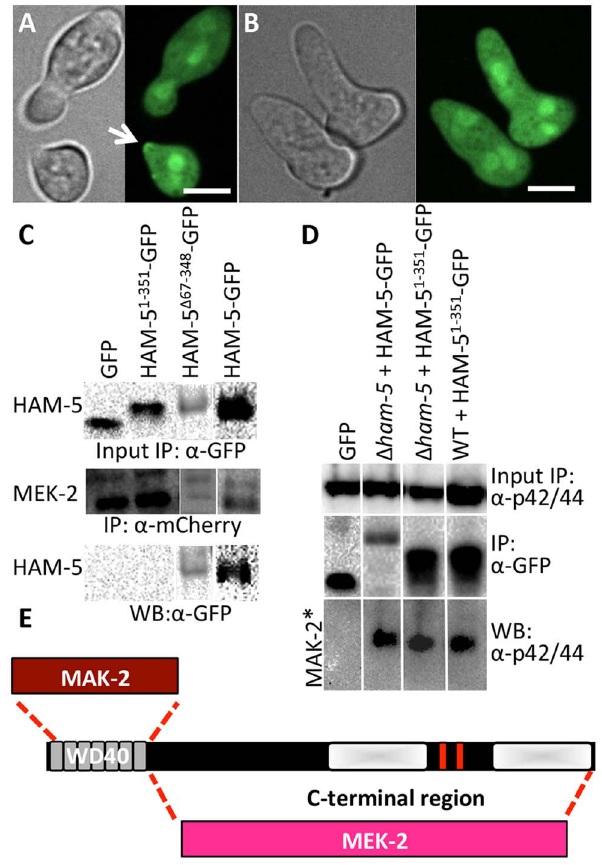
Figure 4. The WD40 domain of HAM-5 interacts with MAK-2, while the C-terminus interacts with MEK-2. (A) Localization of HAM-5 1-351 -GFP (WD40 domain only) in WT germlings localized to the cytoplasm, the nucleus and the puncta at the cell periphery and at the tip during chemotropic interactions and oscillation (arrow). (B) HAM-5 1- 351 -GFP in D ham-5 germlings localized to the cytoplasm and the nucleus; no puncta were observed. The images on the left are bright field images. Scale bar =10 m M. (C) Western blots showing a specific interaction between MEK-2-mCherry (82.9 kD) with full length HAM-5- GFP (210 kD) or HAM-5 D 67-348 -GFP (180 kD), but not with free GFP (27 kD; Figure S4C, D). An interaction between MEK-2-mCherry and HAM-5 1-351 -GFP (65.3 kD) was not detected. Input panels show Western blot of immunoprecipitated proteins isolated from 5 hr-old germlings probed with either anti-mCherry antibodies or anti-GFP antibodies. Output panel shows anti-mCherry immunoprecipitated proteins (MEK- 2-mCherry) probed with anti-GFP antibodies (HAM-5-GFP). (D) Western blots showing a specific interaction between full length HAM-5-GFP or HAM-5 1-351 -GFP and phosphorylated MAK-2. Input panels show Western blot of proteins isolated from 5 hr-old germlings probed with anti-p42/44 antibodies (which recognize phosphorylated MAK-2 (40.8 kD; Figure S4D, E) [8]) or immunoprecipitated proteins probed with anti-GFP antibodies. The output panel shows anti-GFP immuno- precipitated protein sample probed with anti-p42/44 antibodies, showing interaction between HAM-5-GFP or HAM-5 1-351 -GFP and phosphorylated MAK-2. (E) Schematic showing regions of interaction between HAM-5 and MAK-2 or MEK-2 based on co-immunoprecipita- tion experiments.